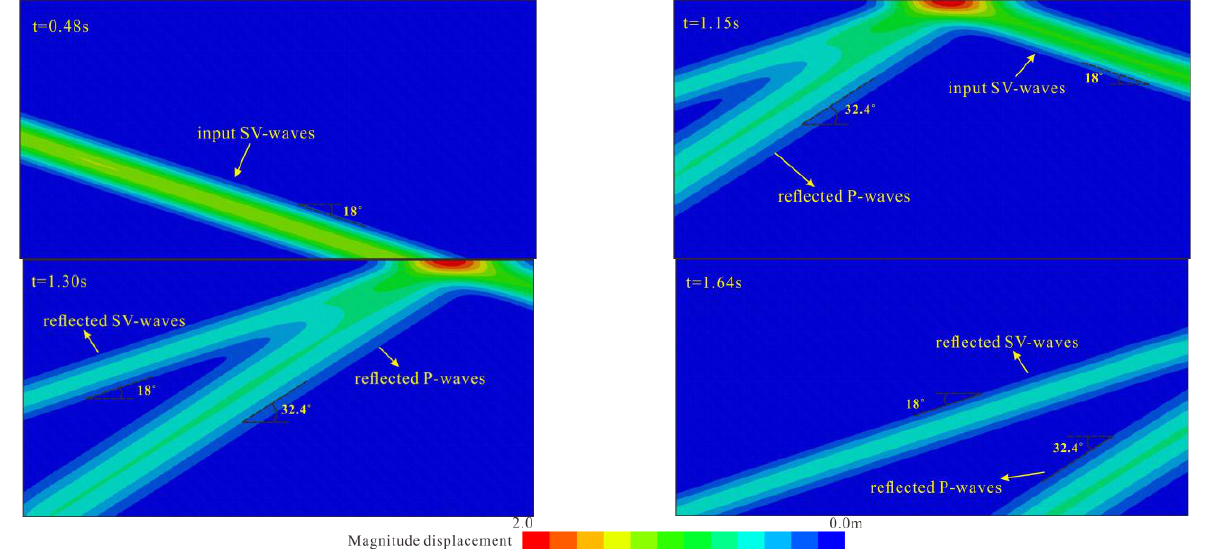
Figure 7. Displacement contours of SV waves propagated in semi-infinite space.